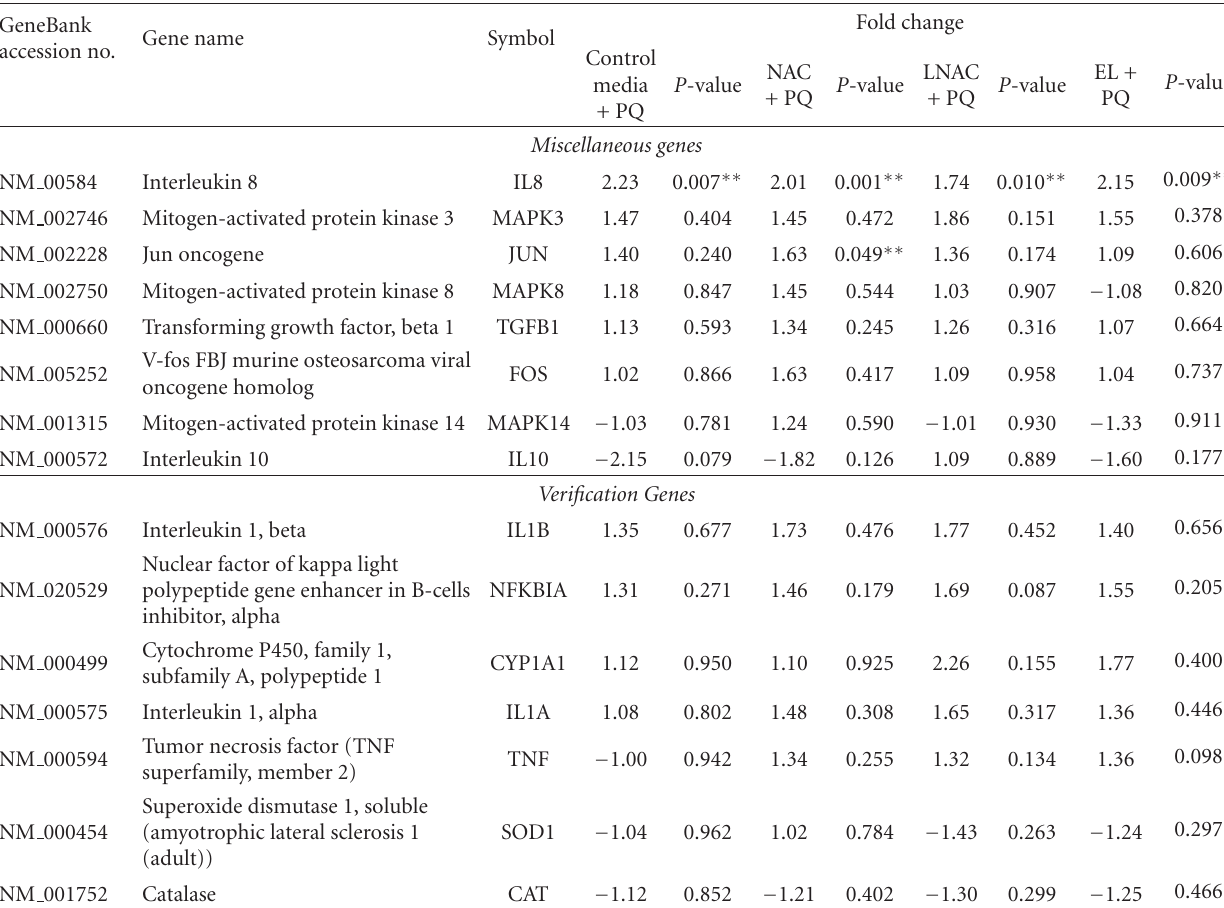
Table 2: Relative expression, via conventional RT-PCR analysis, of genes involved with cellular stress and toxicity in cells challenged with 0.25mM PQ for 4h following pretreatment with control on NAC-, L-NAC- or EL-containing media. Fold change is expressed relative to